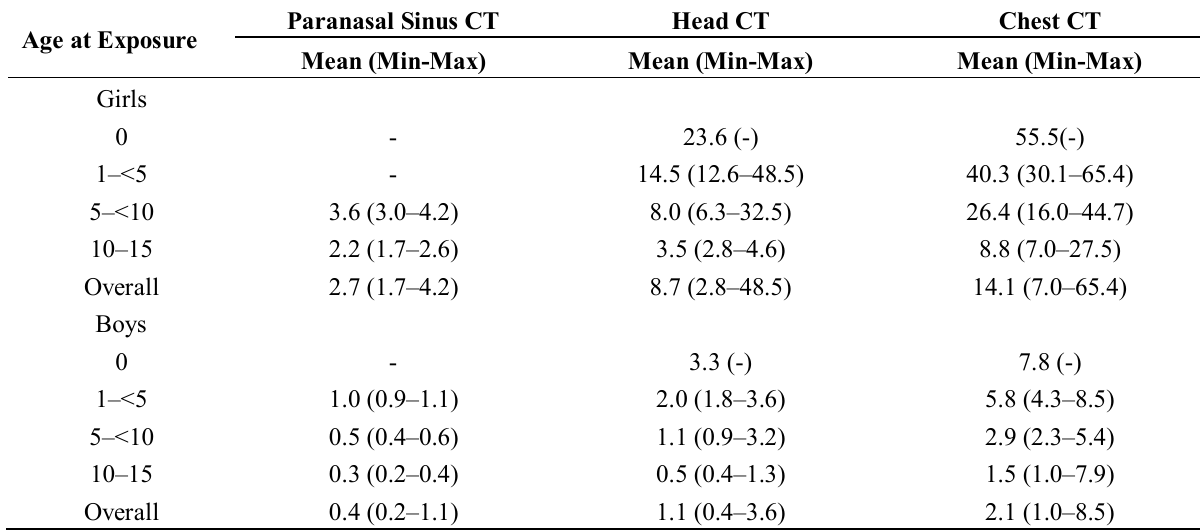
Table 6. Summary of the lifetime attributable risk of thyroid cancer incidence per children based on the different CT protocols in this general